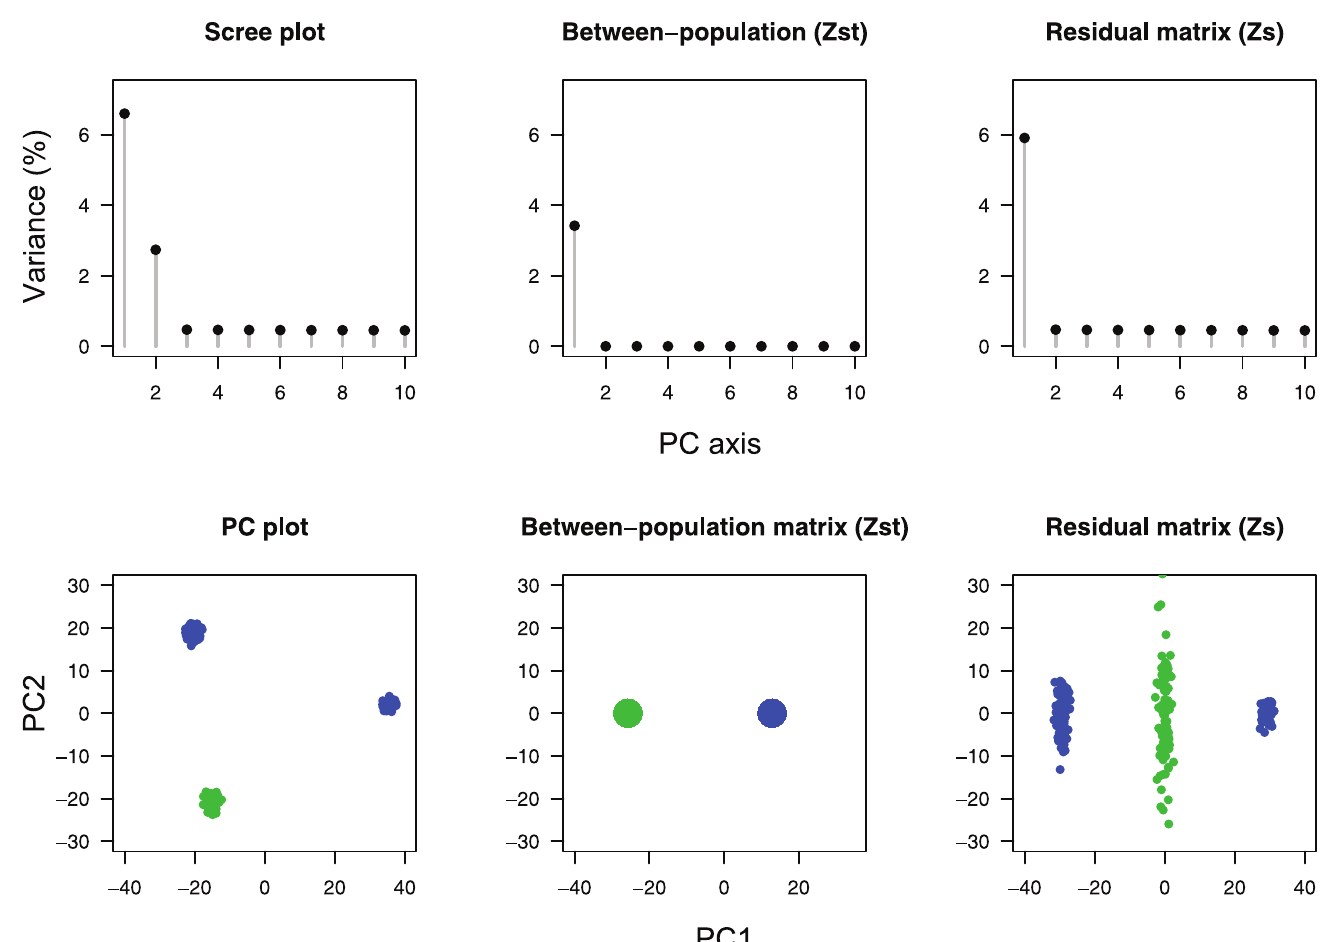
Fig 2. Spectral analysis with incorrectly labelled population samples ( K = 2). For the same genotype matrix as in Fig 1, samples from populations 2 and 3 (blue) were grouped against population 1 (green). PCA scree plots and PC plots for the scaled matrix, Z sc , for the between-population matrix, Z sc matrix, Z sc of simulated data. F ST was lower than the leading eigenvalue of the residual matrix, and it differed from the first PC eigenvalue. S